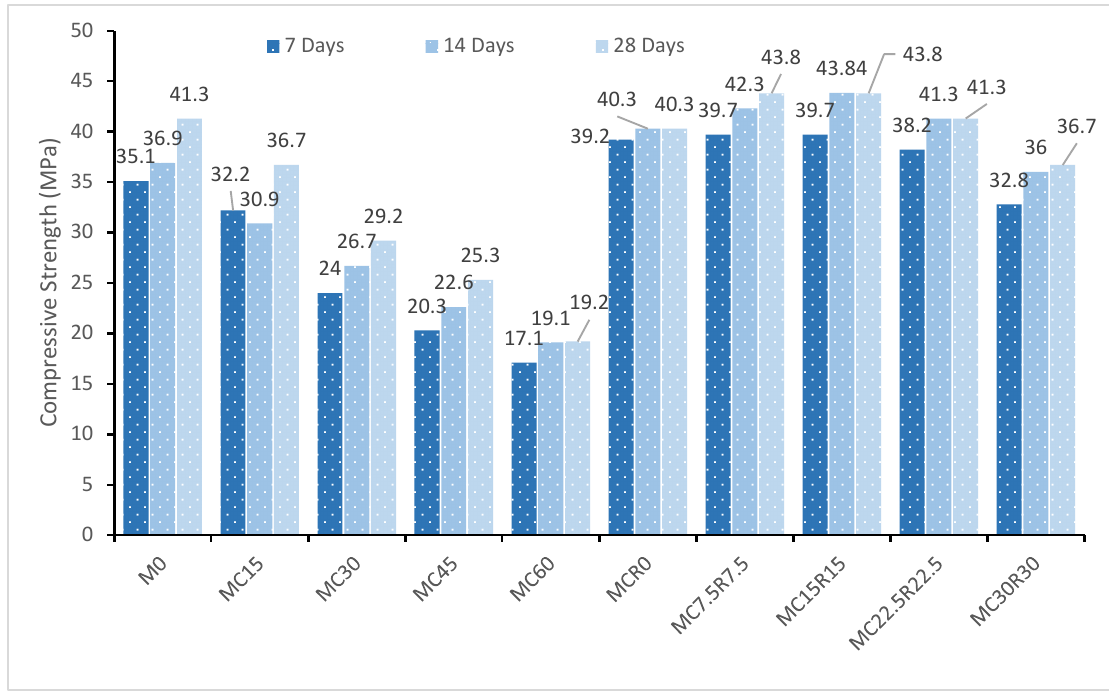
Figure 5. Compressive strength (MPa) of alkali-activated samples at 7, 14, and 28 days.